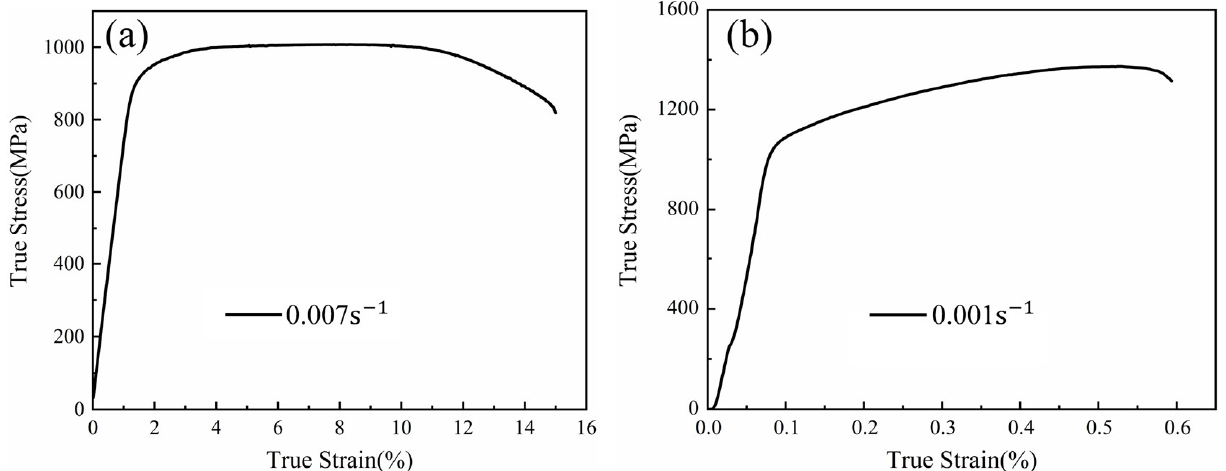
Figure 2. Quasi-static mechanical properties of the Ti-6Al-1Mo-2Zr-0.55Fe-0.1B alloy: ( a ) tension; ( b ) compression. Table 2. Quasi-static mechanical property data of the Ti-6Al-1Mo-2Zr-0.55Fe-0.1B and Ti80 alloys.